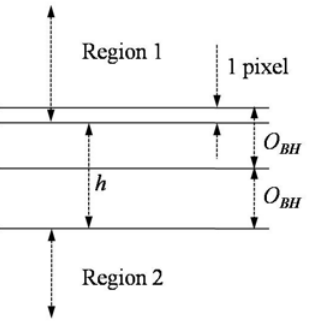
Figure 2. Worst case scenario while ensuring the presence of a block between two vertically adjacent regions. Region 1 and Region 2 are two foreground regions sep- arated by a vertical distance of h pixels, and O BH is the optimal block height.